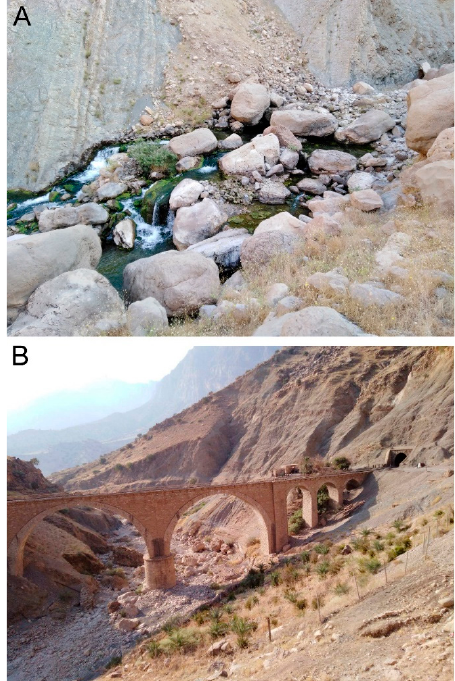
Figure 4. Tuveh spring in rainy season ( A ) and the stream path down to the spring in dry season ( B ).